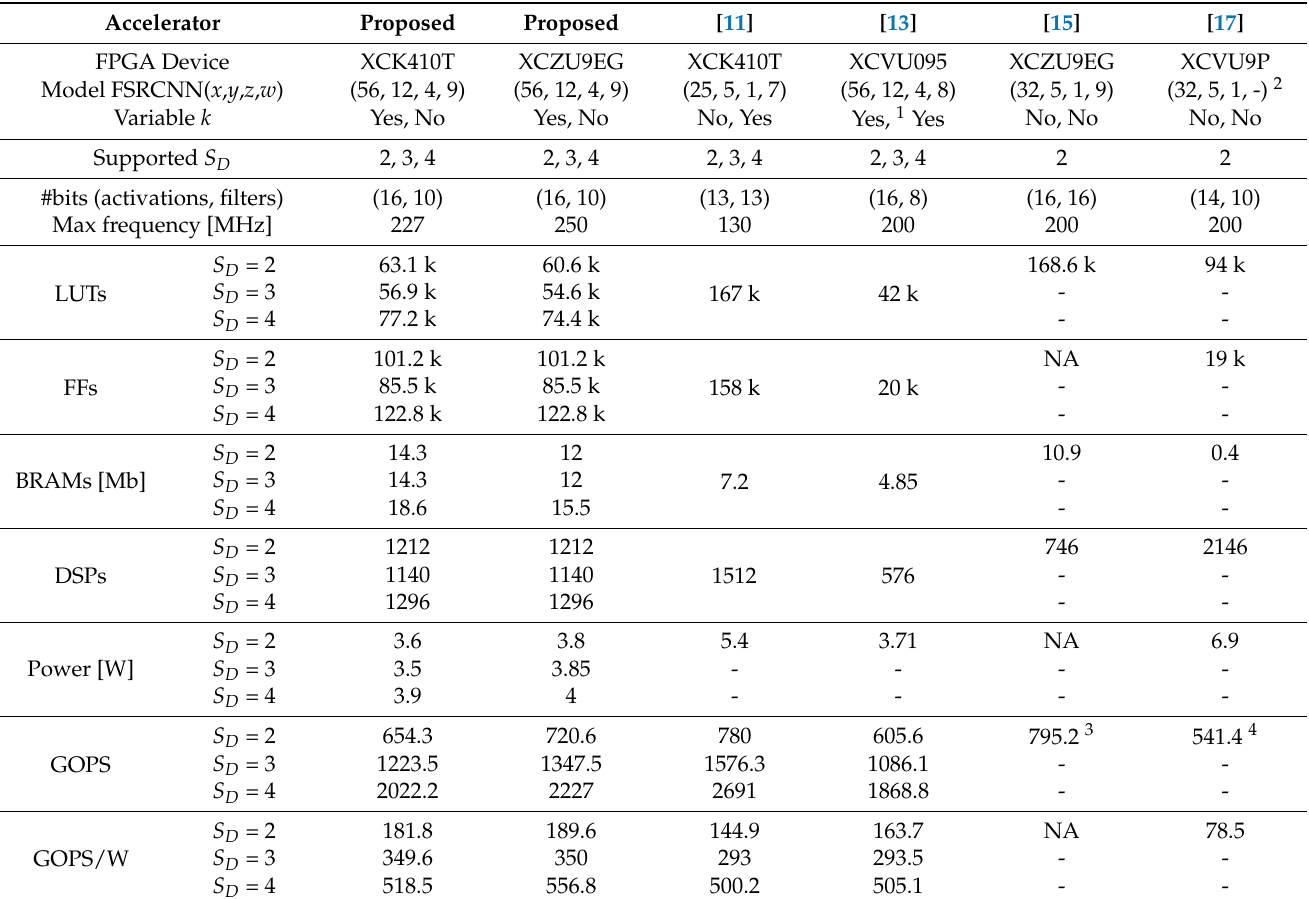
Table 2. Implementation results and comparison with state-of-the-art